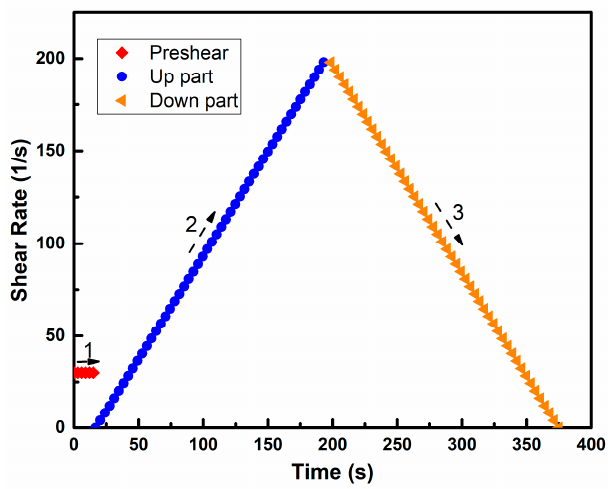
Figure 2. Rheological test procedure of rheometer.